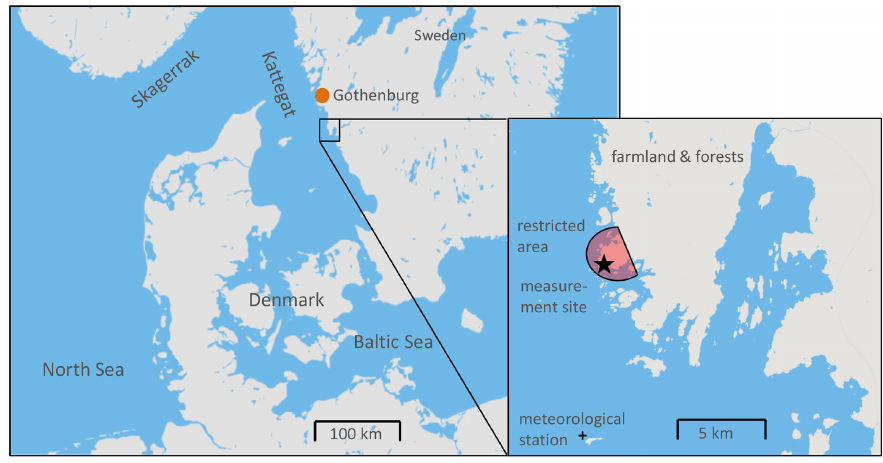
Figure 1. Map of the region and position of the measurement site at the Swedish western